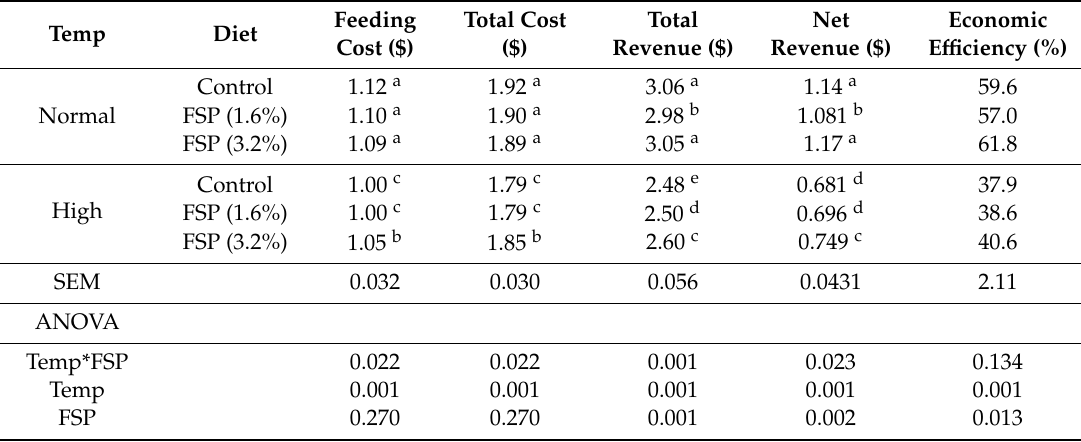
Table 5. Economic e ffi ciency of boilers a ff ected by supplementation with fennel seed powder under thermoneutral or heat stress